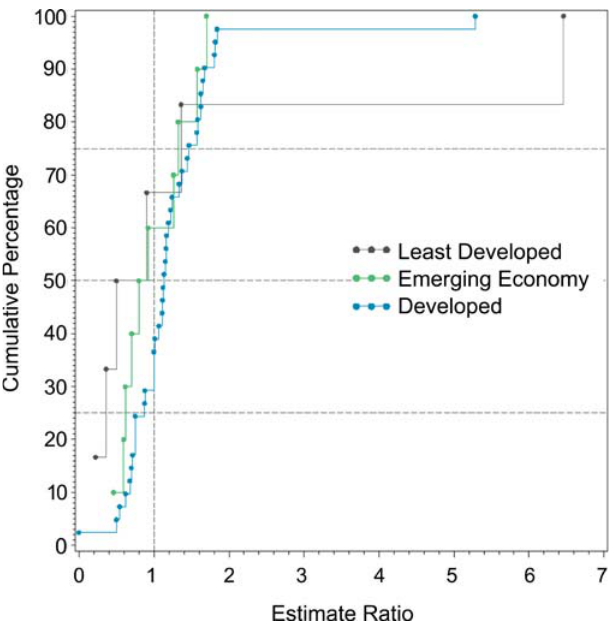
Figure 13. Cumulative Plots of the Male:Female Prevalence Estimate Ratio of Schizophrenia by Economic Status of Country DOI: 10.1371/journal.pmed.0020141.g013